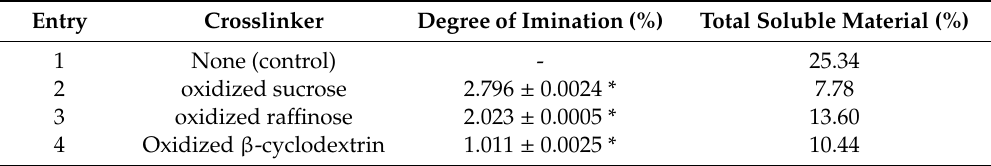
Table 3. Degree of imination measurement results of HTT sea cucumbers. The results are presented as Average ± SD of triplicate experiments.